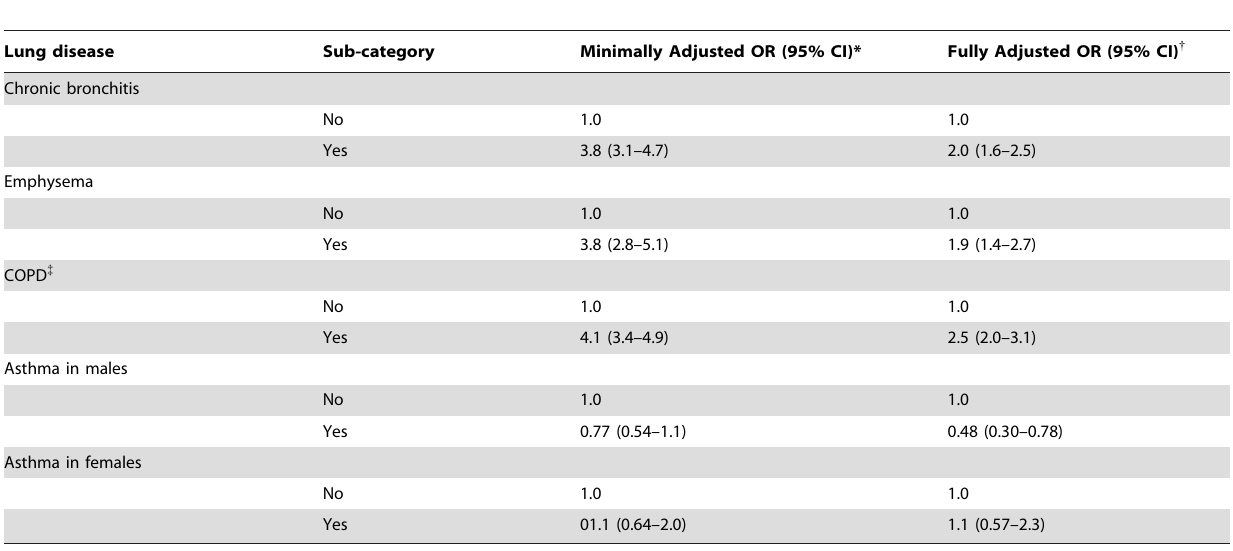
Table 2. Associations of lung cancer with lung disease diagnosed at least one year prior in the Environment And Genetics in Lung cancer Etiology case-control study.